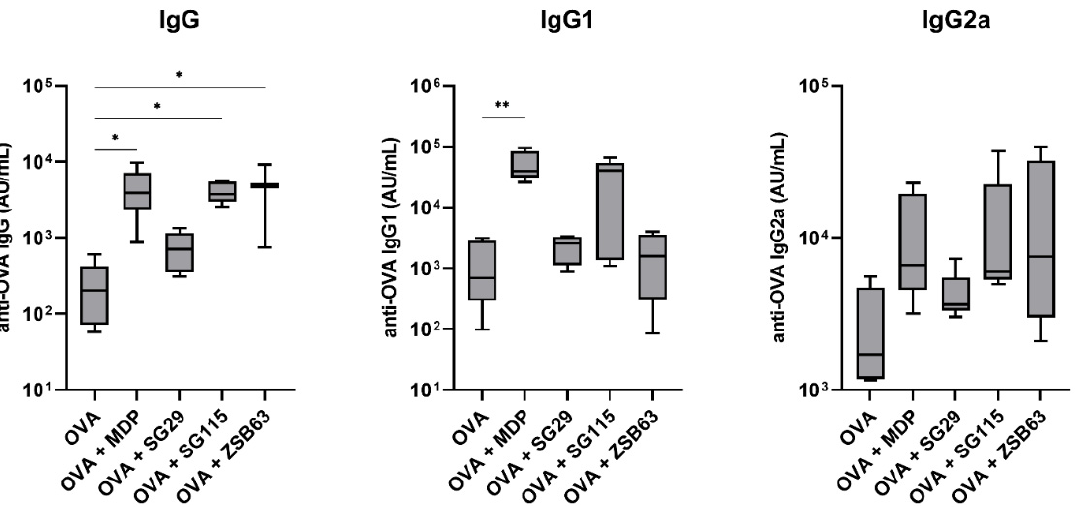
Figure 1. Ovalbumin-specific IgG ( left ), IgG1 ( middle ), and IgG2a ( right ) responses in NIH/OlaHsd mice after immunization with OVA-loaded neutral liposomes (10 µg OVA per dose), adjuvanted with MDP or compounds SG29, SG115, and ZSB63 (0.30 µmol adjuvant per dose). The concentrations were measured one week after the booster dose. Data are means ± SEM of 5 mice per group. *, p < 0.05; **, p < 0.001.